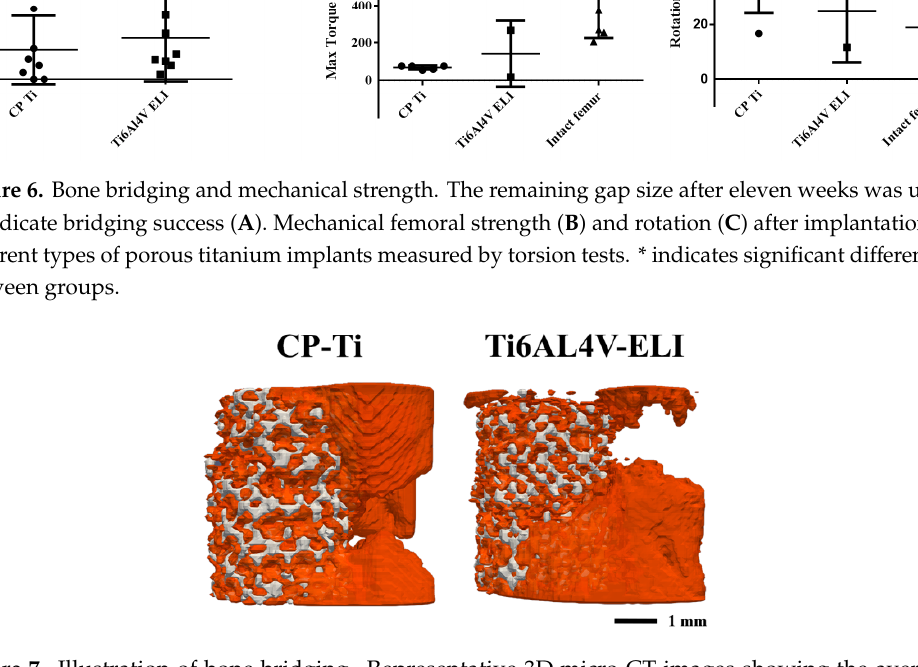
Figure 7. Illustration of bone bridging. Representative 3D micro-CT images showing the average extend of bone bridging of the CP-Ti and the Ti6Al4V-ELI titanium implants.